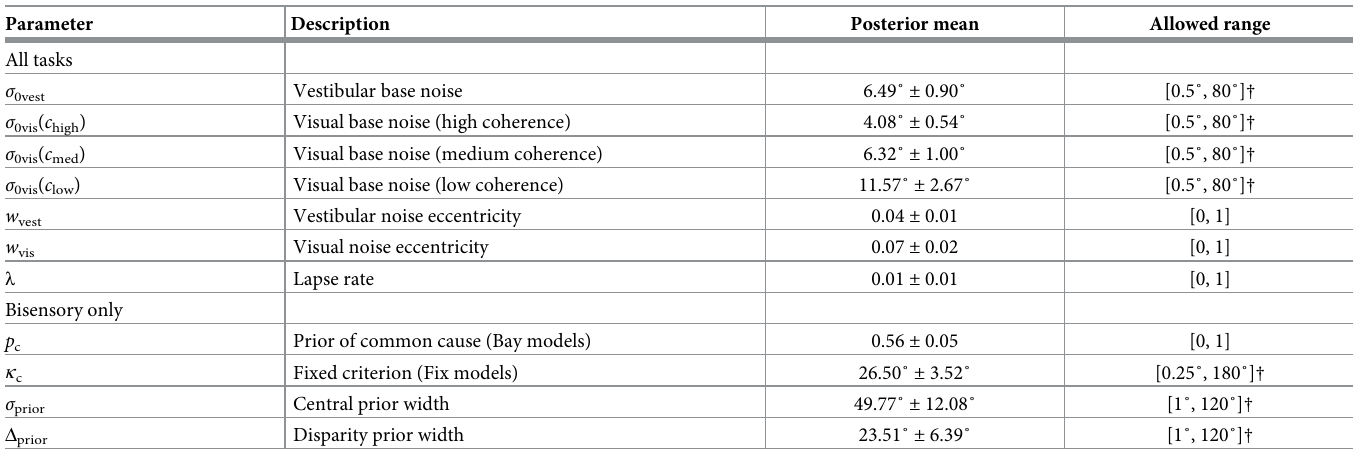
Table 2. Joint fit